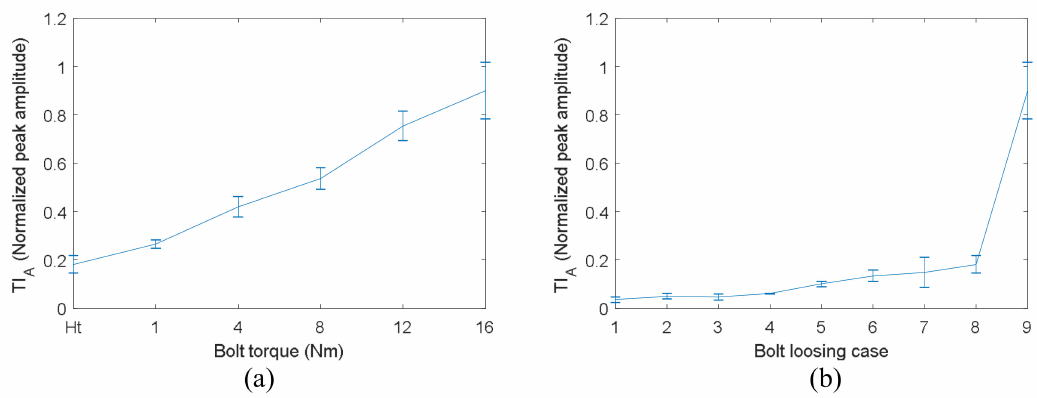
Figure 12. TI A measured by VTR method versus bolt tight condition for four-bolt structure: ( a ) different torques of bolt 2; ( b ) different number of loosening bolts.